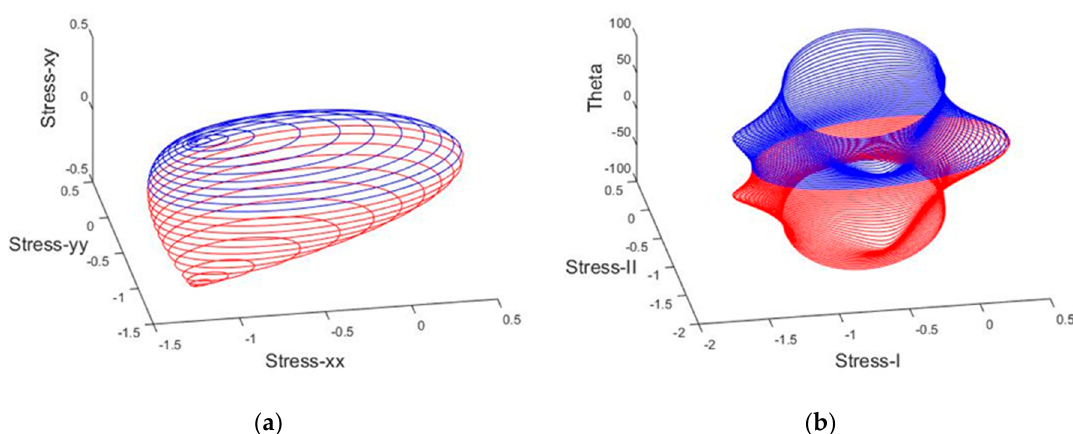
Figure 2. Non-dimensionless failure surface of masonry material using the cubic tensor polynomial failure criterion: ( a ) non-dimensionless normal stress terms; ( b ) non-dimensionless principal stress terms.